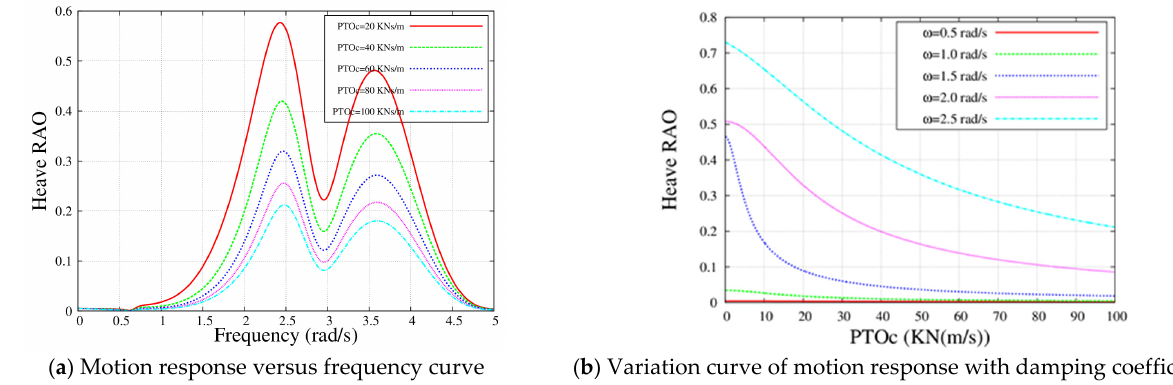
Figure 10. Effect of damping and frequency on motion response of the MJWEC